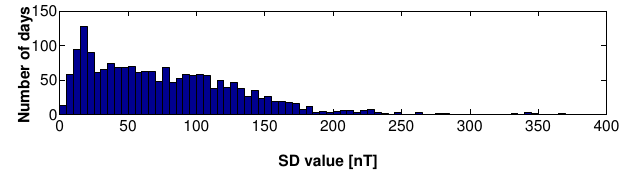
Figure 2. A typical yearly distribution of daily SD values of ground magnetic X component for Region 2 in 2004. The median value of this distribution is 65nT and the mode is